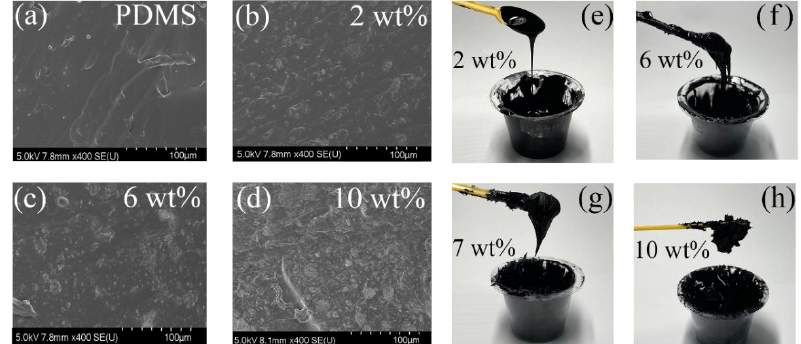
Figure 3. SEM image of CNT-PDMS composites with different weight ratio and photograph of CNT-PDMS composites; ( a ) SEM image of PDMS; ( b ) SEM image of 2 wt% CNT-PDMS composites; ( c ) SEM image of 6 wt% CNT-PDMS composites; ( d ) SEM image of 2 wt% CNT-PDMS composites; ( e )